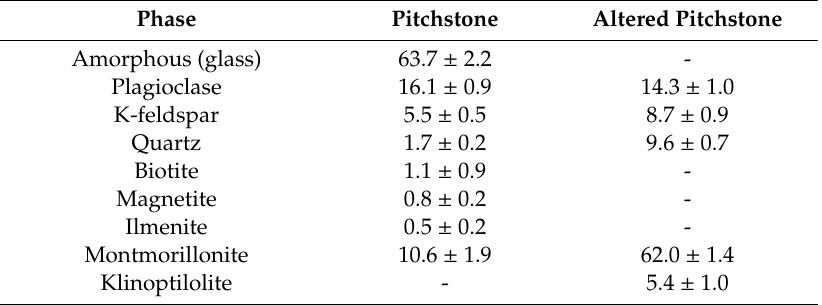
Table 5. Mineral composition (in wt%) of a relatively fresh agate-bearing pitchstone from Chemnitz, Saxony (Germany) in comparison to the surrounding altered